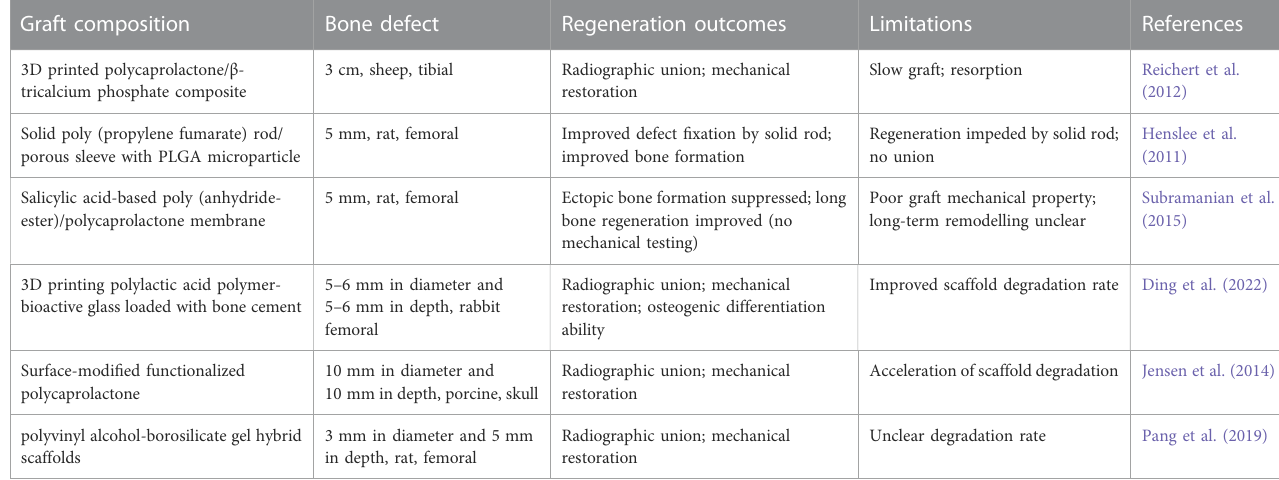
TABLE 1 Synthetic biodegradable polymer materials for bone defects (Henslee et al., 2011; Reichert et al., 2012; Jensen et al., 2014; Subramanian et al., 2015; Pang et al., 2019; Ding et al., 2022). Graft